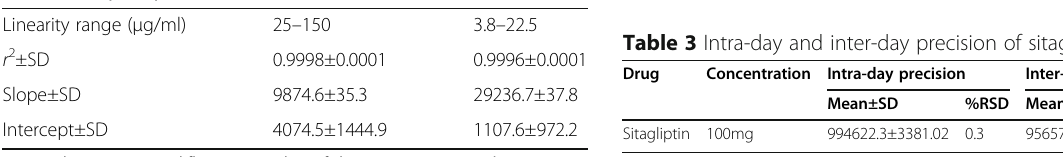
Table 2 Linear regression data for calibration curves ( n =3) Parameters (units)